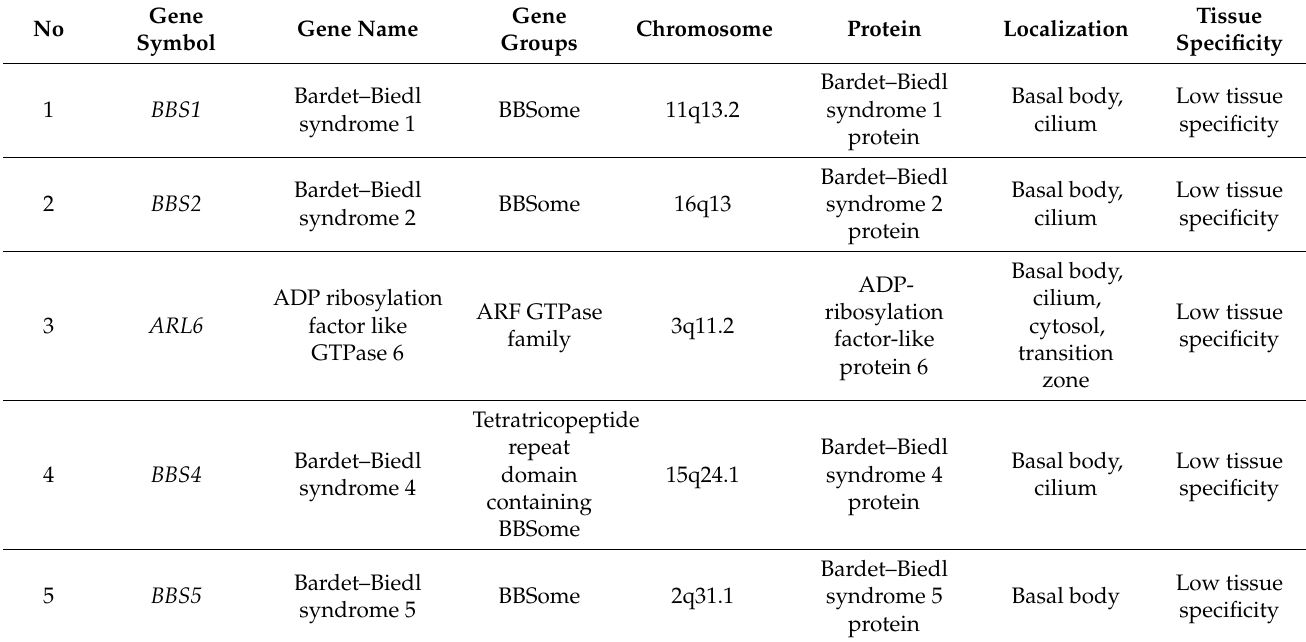
Table 1. Genes in Bardet–Biedl Syndrome: characteristics, tissue, and single cell type specificity